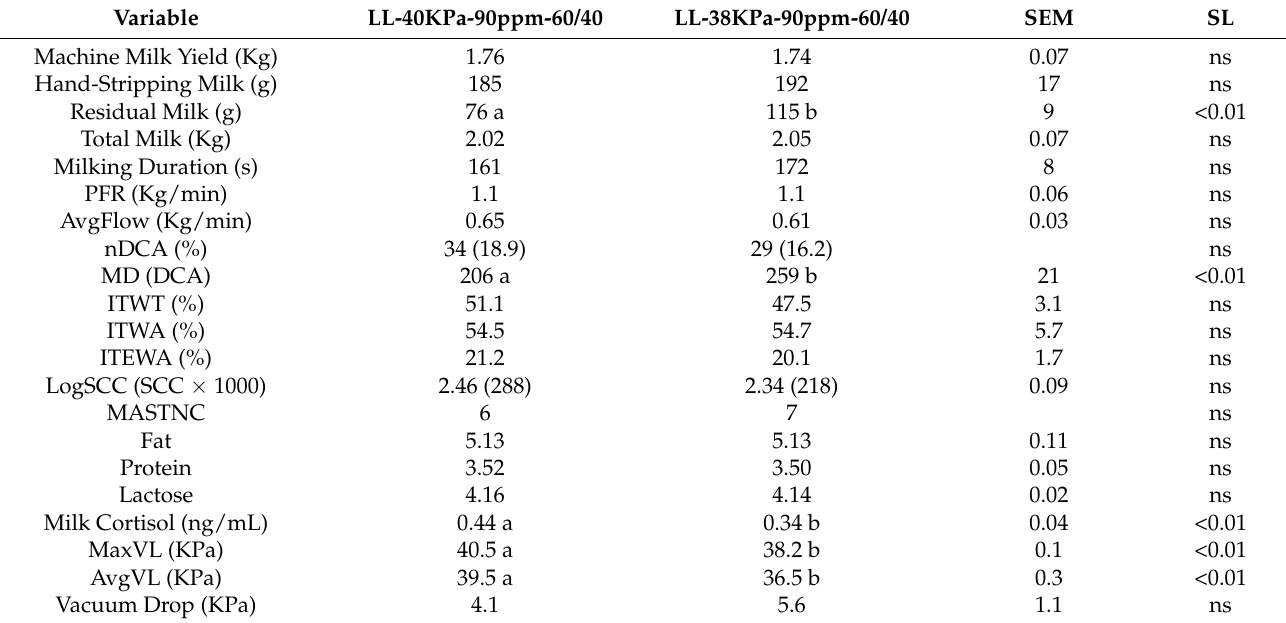
Table 2. Experiment developed in low-lines pipes milking system: results of the variables studied (least square means ± standard error of the mean) according to the different combinations of system vacuum level and pulsation